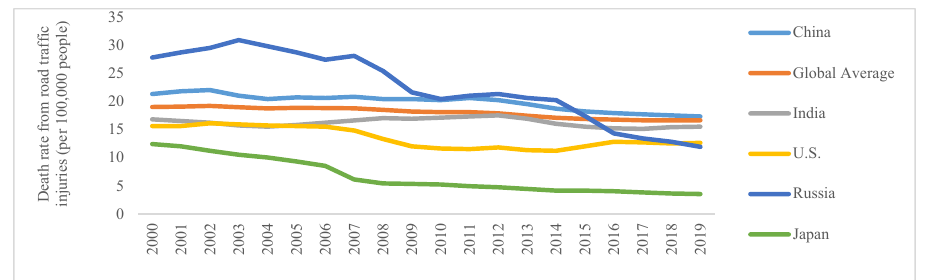
Figure 3. Comparison of death rates from road traffic injuries (per 100,000 people) in major countries. Source: data compiled from World Bank, 2021 [22].